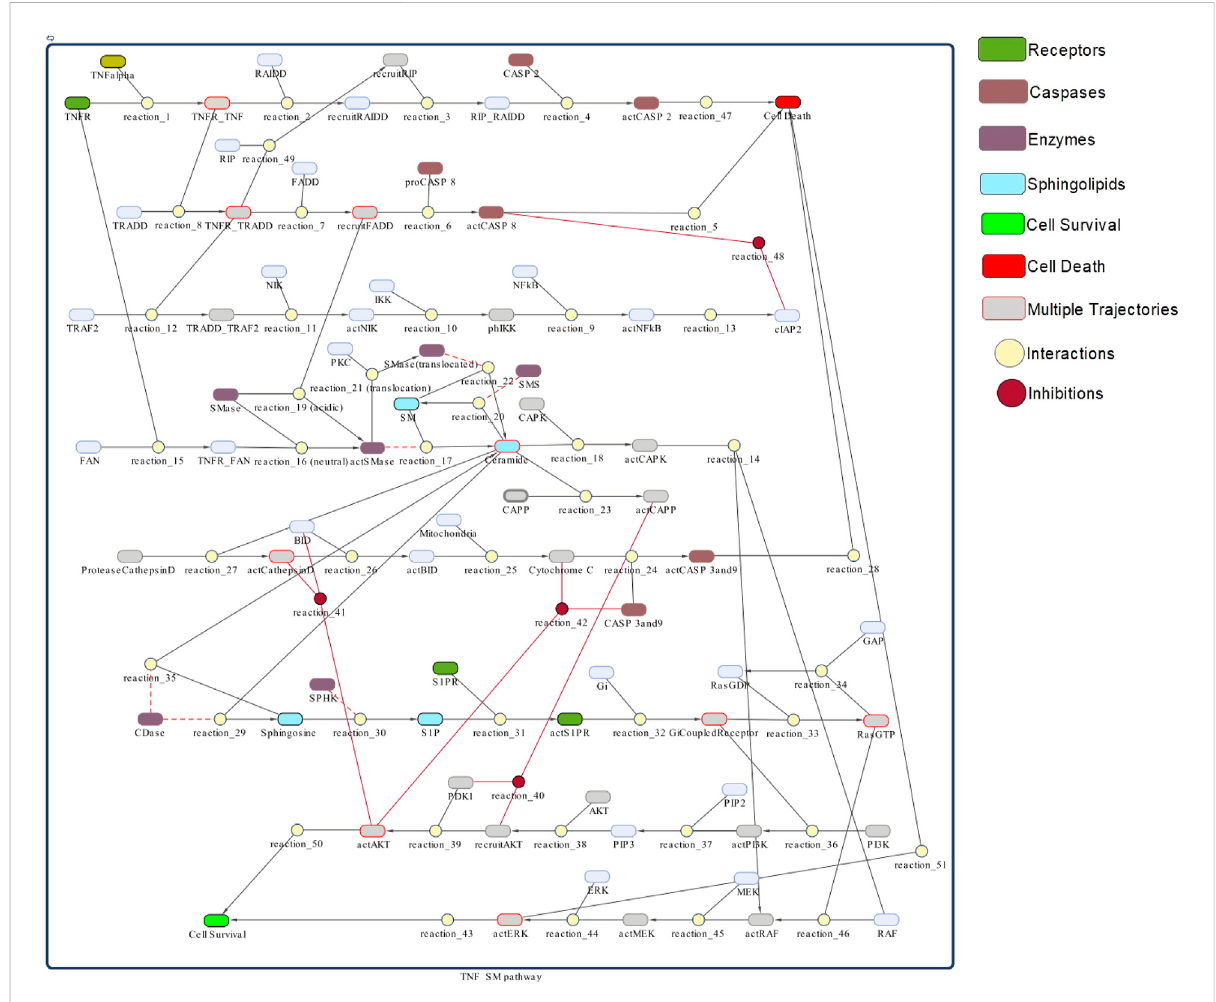
FIGURE 3 TNF- α mediated sphingomyelin signaling pathway model- The whole model is depicted as a network of species (oval) and interactions (circle) connectedbylines/edges.Speciesrepresentbiologicalentities(receptors, ligands, proteins,enzymes)ofthepathway:green colorshowsreceptors, grape color shows caspases, mauve color shows enzymes related to sphingomyelin pathway, light seagreen color shows sphingolipid molecules, bright green color shows cell survival and red color shows cell death. Interactions 1 – 51 represent processes like transformation, transport, binding/unbinding, activation/inhibition: wine color represents inhibitions. Lines connect species with interactions: red lines show inhibition and dotted lines show read arcs representing reversible effect of enzymes speci fi c to the sphingomyelin pathway. Species with red boundaries have multiple